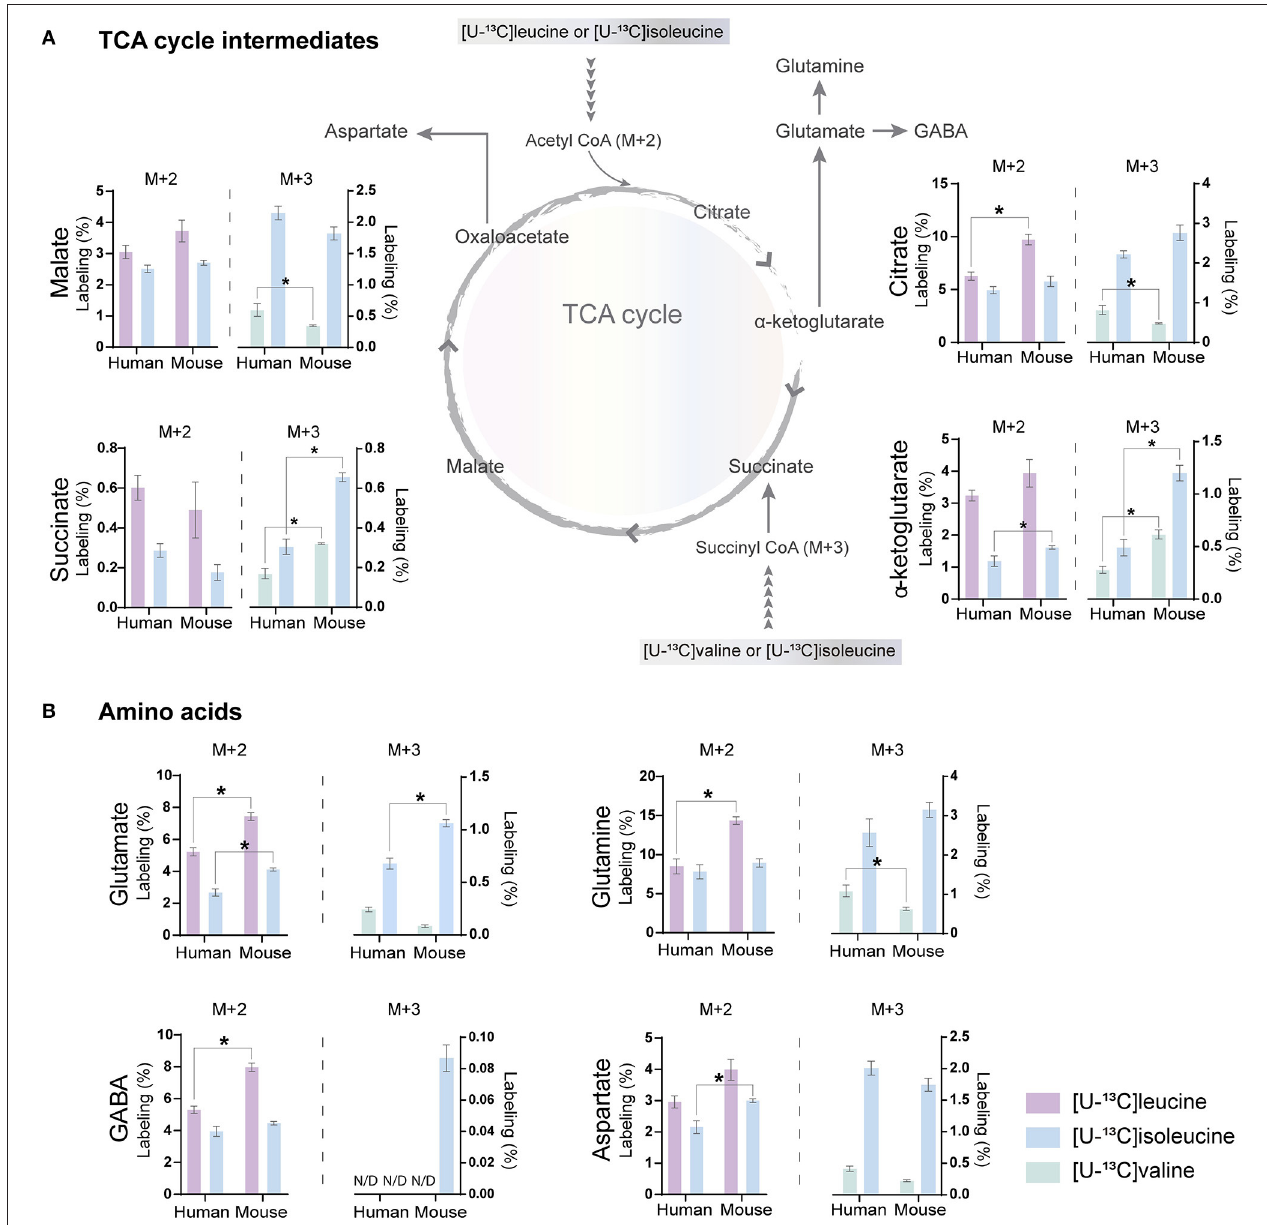
FIGURE 3 | BCAA oxidative metabolism in human and mouse brain slices. 13 C-enrichment of tricarboxylic acid (TCA) cycle metabolites and amino acids in human and mouse cerebral cortical slices after incubation with [U- 13 C]isoleucine, [U- 13 C]leucine, or [U- 13 C]valine. M + 2 and M + 3 13 C-enrichment in (A) TCA cycle intermediates. Increased M + 2 13 C-enrichment in (B) glutamate, glutamine, and GABA after incubation with [U- 13 C]leucine in mouse cortical slices when compared with human cortical slices. 13 C-enrichment in intracellular metabolites was determined by GC-MS. Values represent mean ( ± ) SEM ( n = 6), * p < 0.05 analyzed by two-way ANOVA. N/D, not